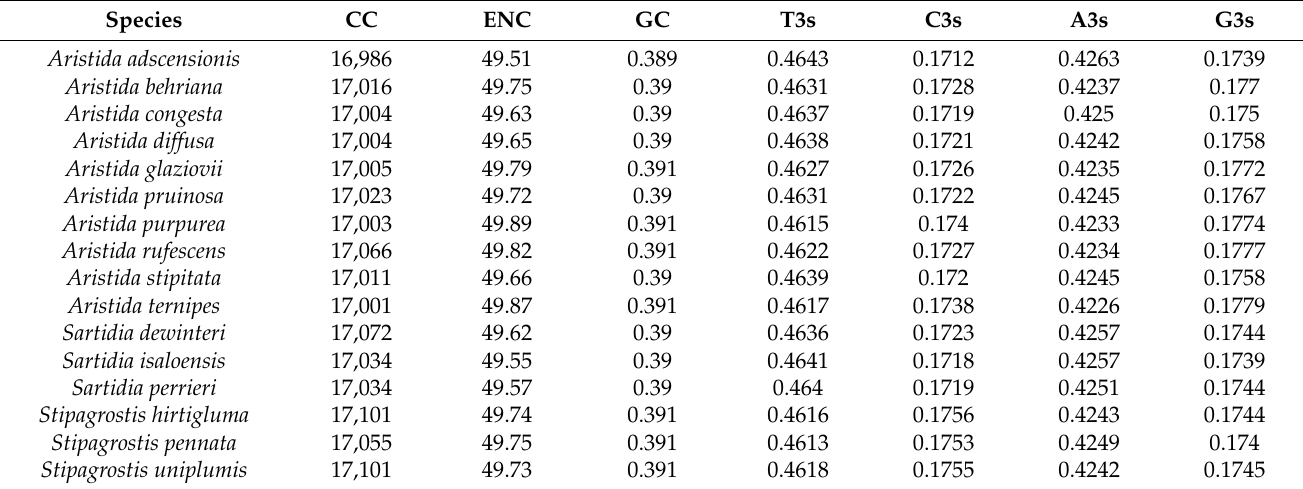
Table 4. The codon usage of 16 Aristidoideae plastomes.